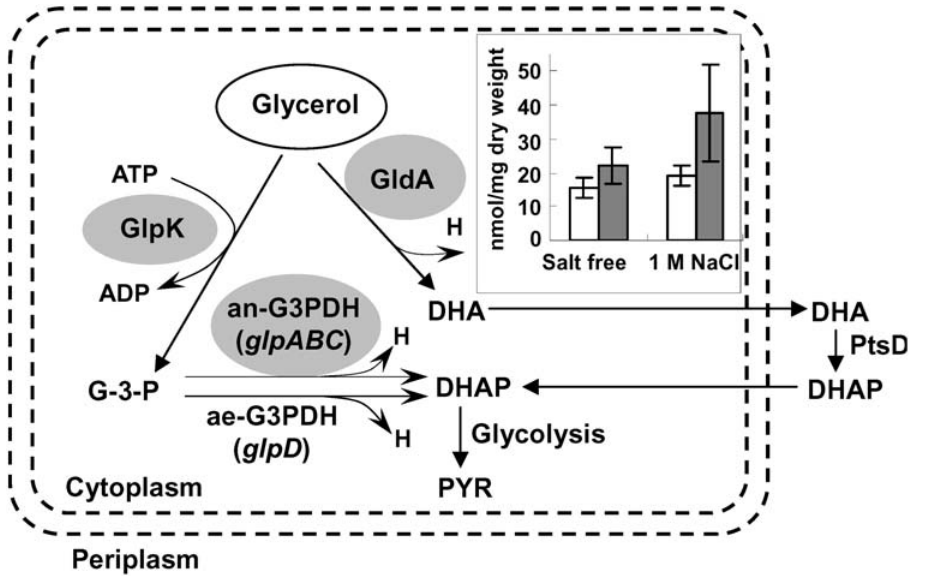
Figure 5. Schematic representation of the E.coli glycerol dissimilation pathways and the change in intracellular glycerol content. Expression levels of the major enzymes were found to be decreased by at least 2-fold (grey shading), as indicated by proteomics analysis. Inset shows the change in intracellular glycerol content in an IrrE-expressing strain ( & ) and a control strain ( % ) after incubation for 1 h with or without 1.0 M NaCl. Data represent the means and standard errors of three replicate experiments in which each sample was assayed in duplicate. Statistical significance was determined by Student’s t test (n=6, P , 0.05). Abbreviations: GlpK, ATP-dependent glycerol kinase; GldA, Glycerol dehydrognease; ae-G3PDH, aerobic G3PDH; an-G3PDH, anaerobic G3PDH; PtsD, DHA-specific enzyme II; H, reducing equivalents (H=NADH/NADPH); GPD, glycerophosphoryl diester; DHA, dihydroxyacetone; DHAP, dihydroxyacetone phosphate; PYR, pyruvate.